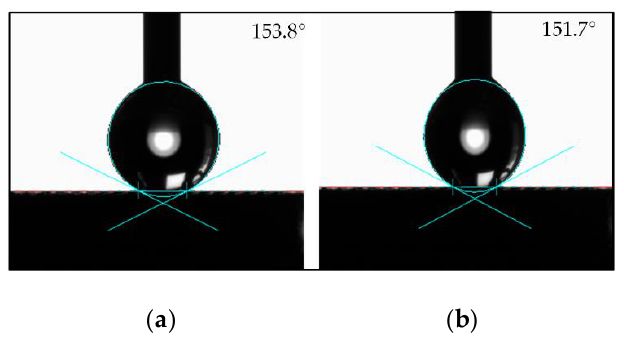
Figure 8. The contact angle hysteresis of F Ti: ( a ) Advancing contact angle θ A . ( b ) Receding contact angle θ R